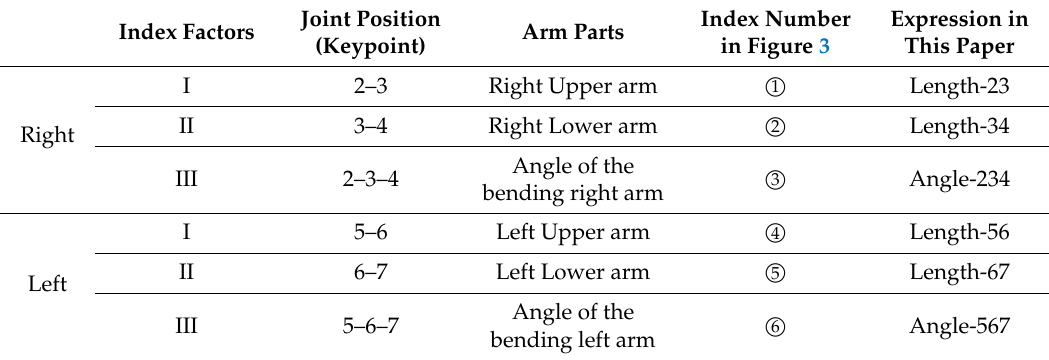
Figure 3. Focusing parts in proposed approach. Table 1. Correspondence between joint position and body part.